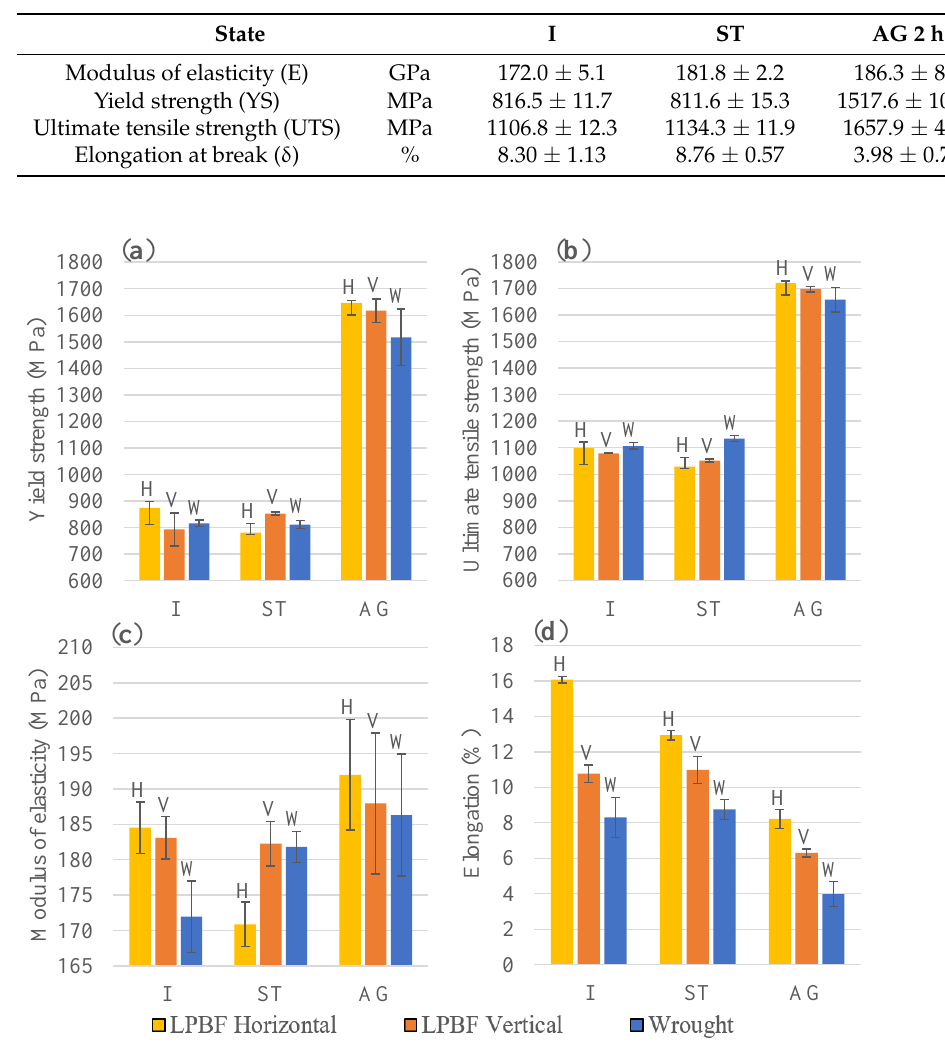
Table 3. Mechanical properties of the LPBF alloy at different processing states.